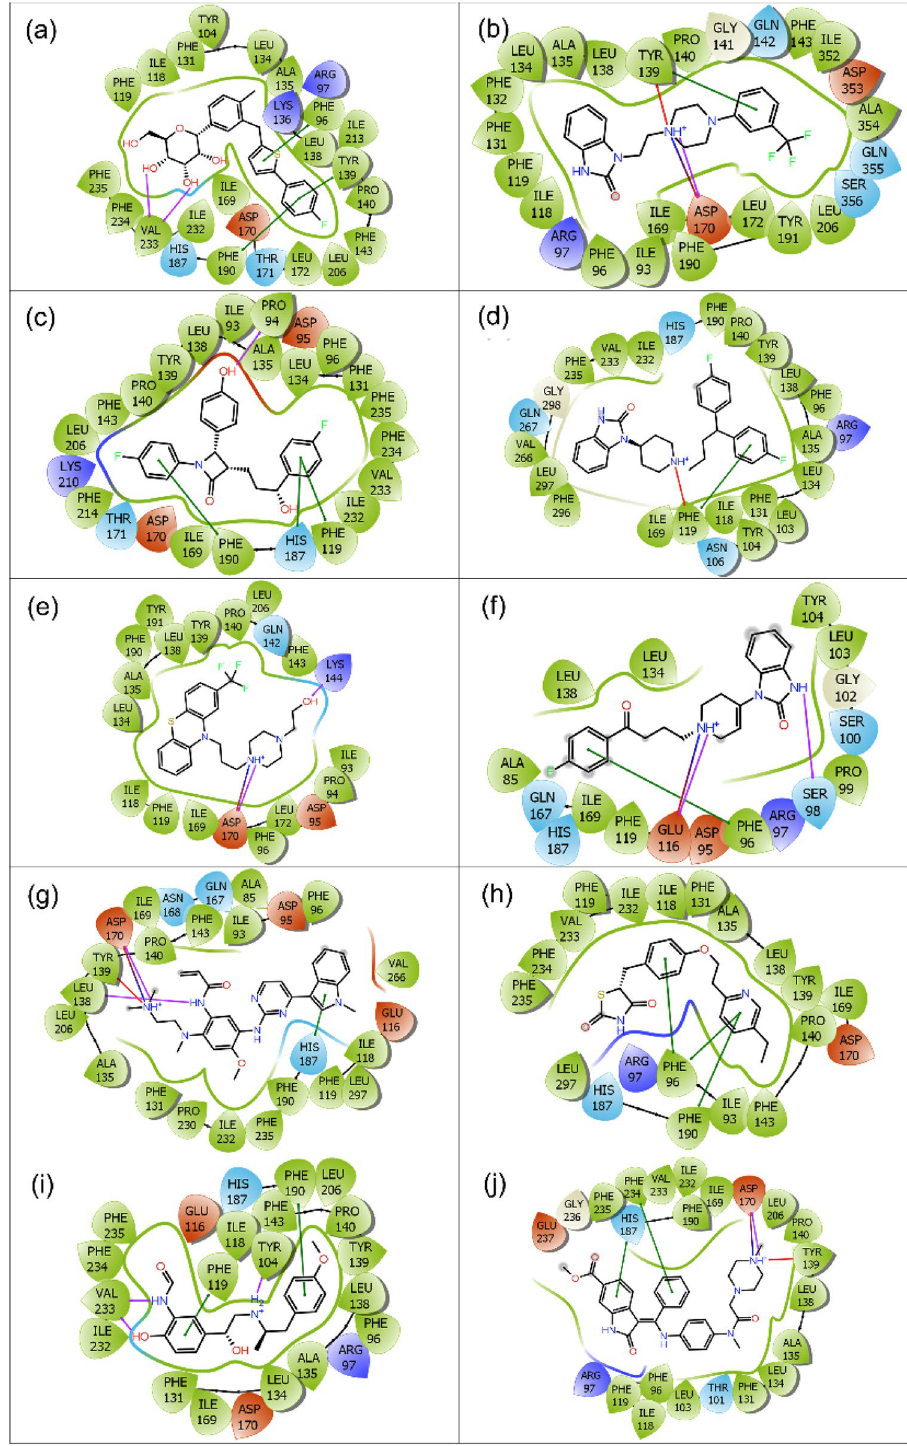
Figure 5. 2D molecular contacts profiling for the last poses of Sirt2-FDA-approved drugs, viz. ( a ) Canagliflozin, ( b ) Flibanserin, ( c ) Ezetimibe, ( d ) Pimozide, ( e ) Fluphenazine, ( f ) Droperidol, ( g ) Osimertinib, ( h ) Pioglitazone, ( i ) Formoterol, and ( j ) Nintedanib, were extracted from 100 ns MD simulation. These poses exhibit hydrogen bond (pink arrows), π–π (green lines), π–cation (red lines), hydrophobic (green), polar (blue), negative (red), positive (violet), glycine (grey), and salt bridge (red-violet line) interactions in respective extracted snapshots. Images were rendered using academic Schrödinger-Maestro v12.4 suite 43 (URL: https:// www. schro dinger. com/ freem